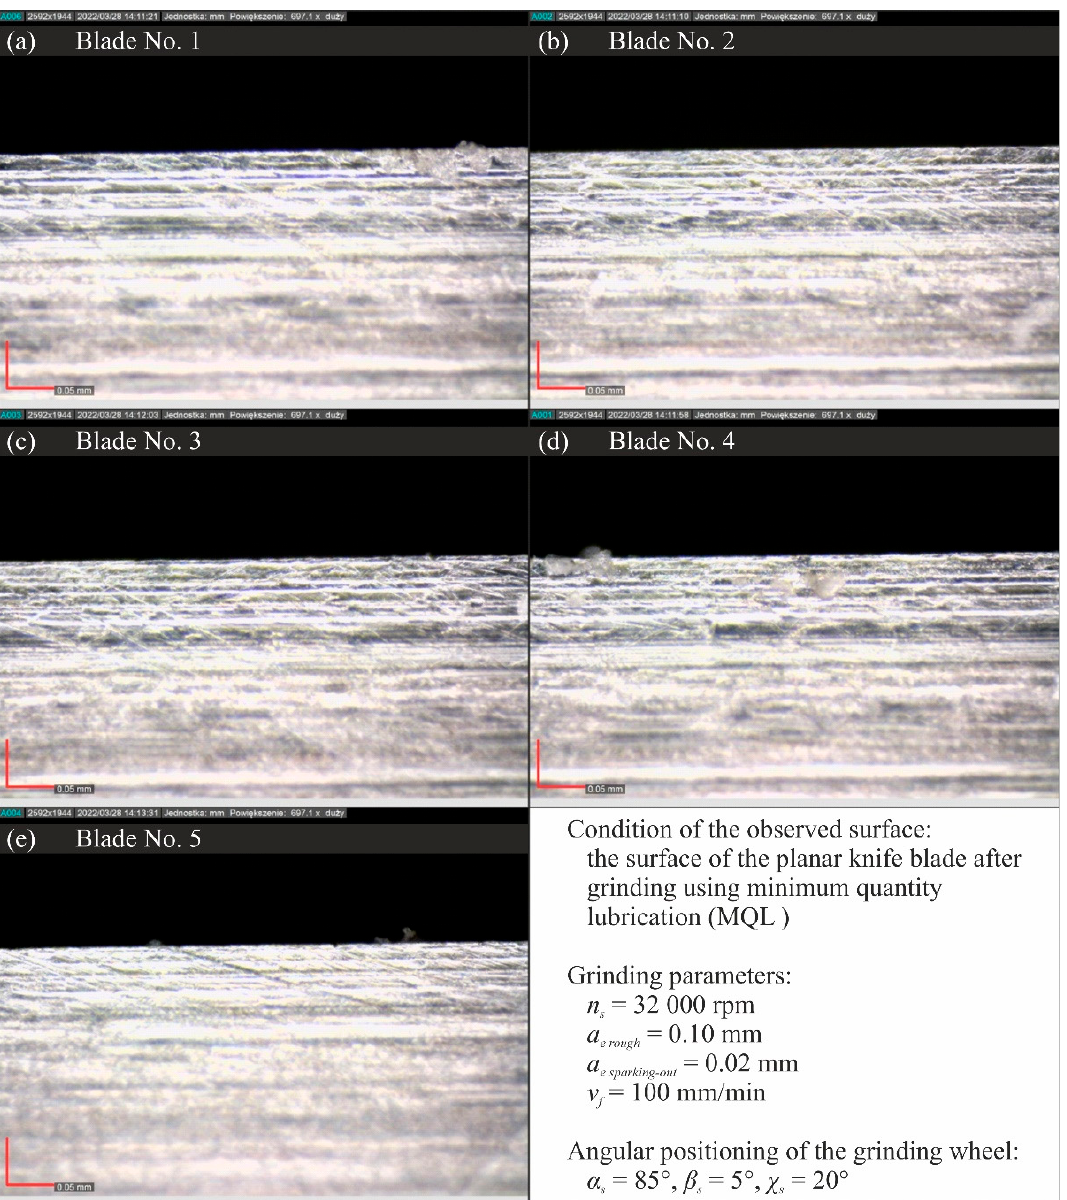
Figure 16. Microscopic views of the blade surfaces of five planar knives shaped using the MQL method recorded with a Dino-Lite Edge AM7515MT8A digital measuring microscope from AnMo Electronics Corp. (New Taipei City, Taiwan, China) at a magnification of approximately 700×: ( a ) blade No. 1; ( b ) blade No. 2; ( c ) blade No. 3; ( d ) blade No. 4; ( e ) blade No. 5.